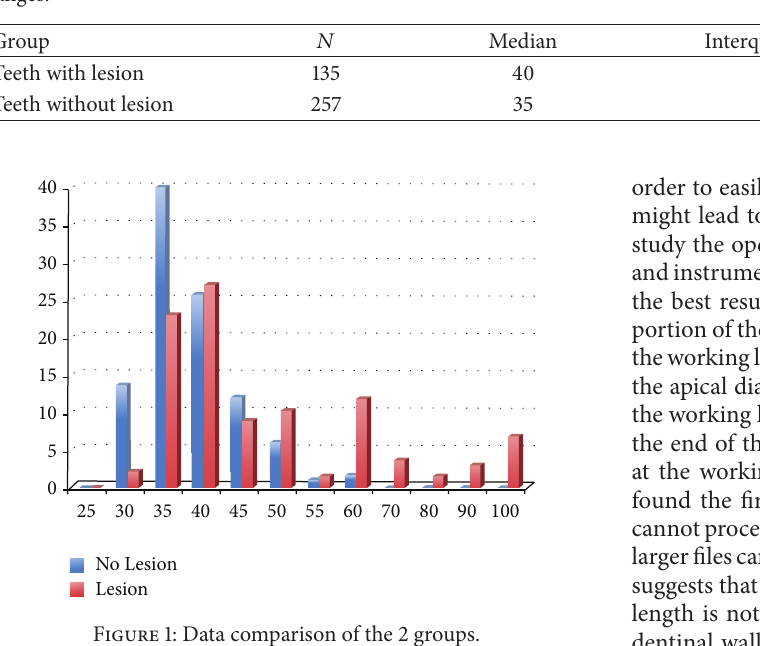
Table1:Ratioofdiametersintheapicalpartofrootcanalinteethwithandwithoutperiapicallesions:allpresentedasmedianandinterquartile ranges.